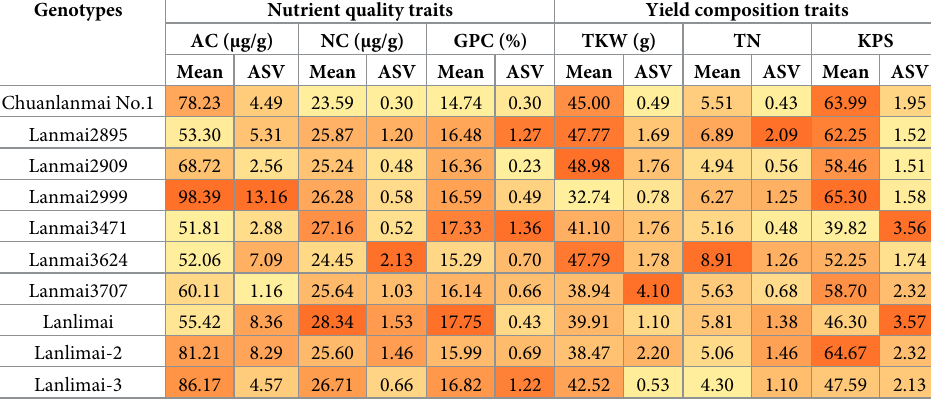
Table 5. Average and AMMI stability value (ASV) of nutrient quality traits and yield composition traits for the blue wheat lines. Genotypes Nutrient quality traits Yield composition